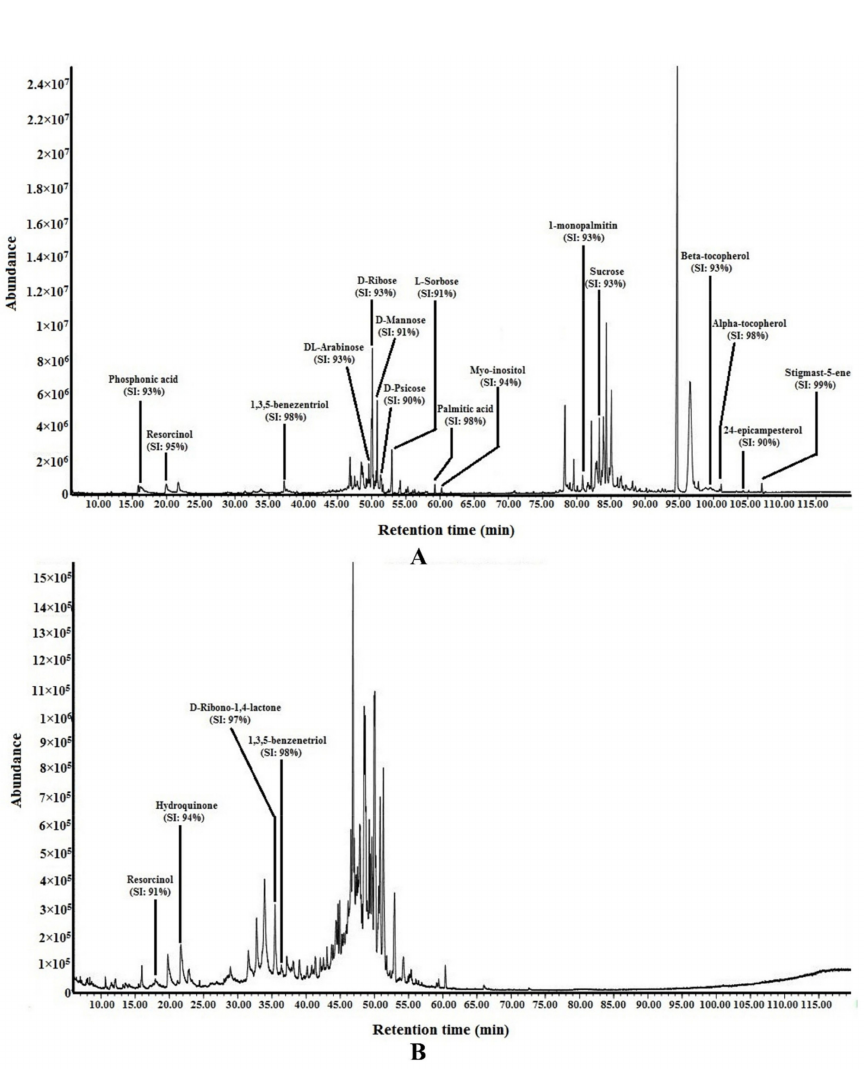
Figure 6. GC-MS chromatogram of derivatized methanol extract ( A ) and water extract ( B ) of P. malayana